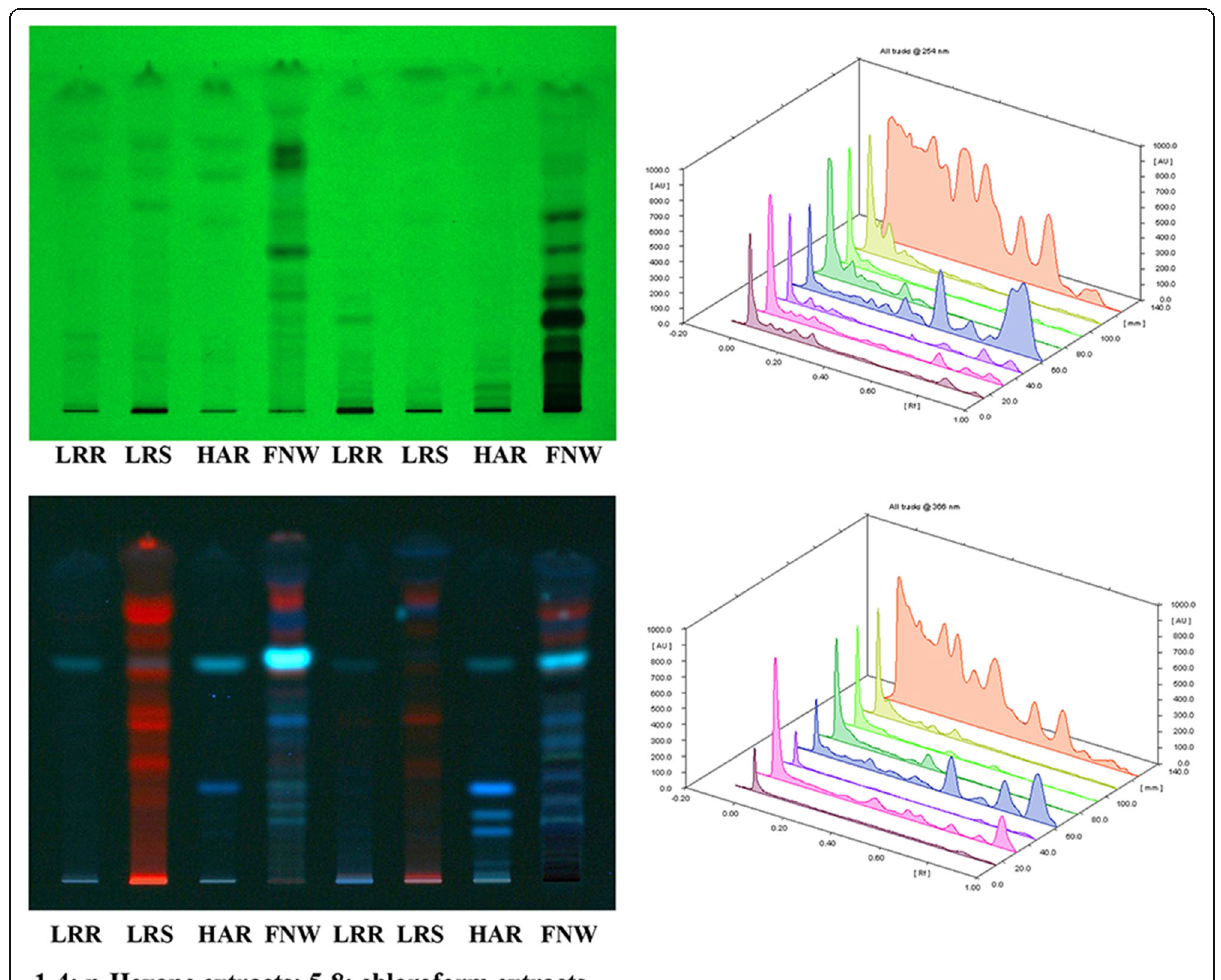
Fig. 2 HPTLC profile of sequential n-hexane and chloroform extracts of various Jivanti source